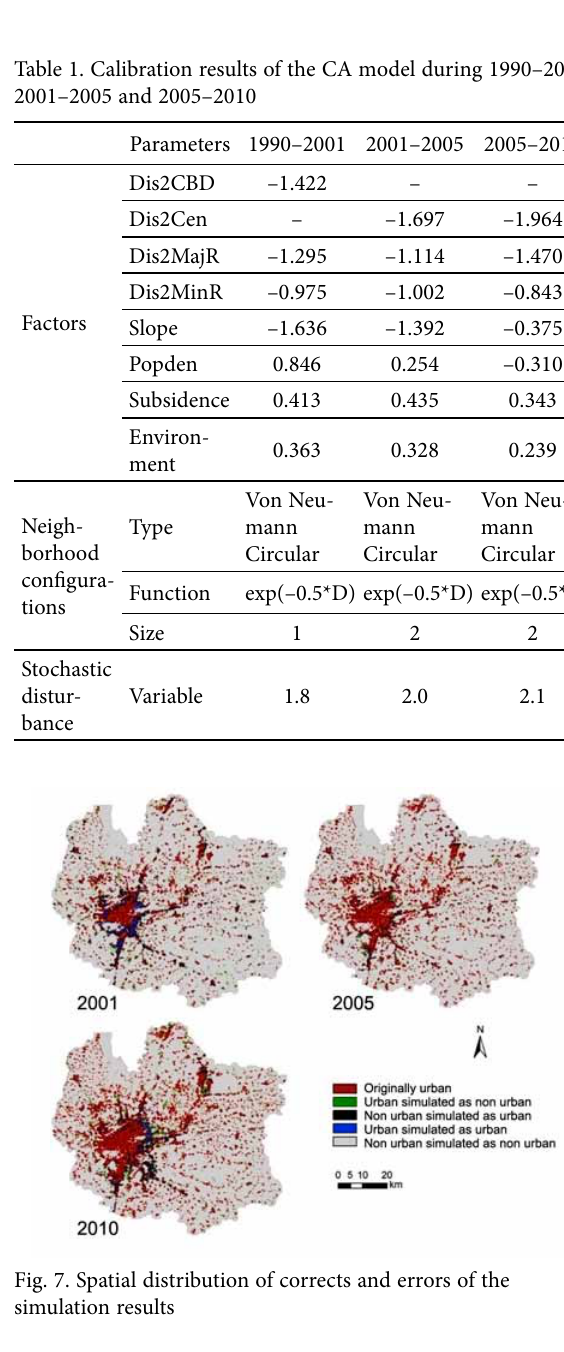
Fig. 6. Variation of figure of merit and Rd values response to neighborhood size and random variable variation: a) – the figure of merit value calculated for different neighborhood sizes and random variables and b) – the Rd value calculated for different neighborhood sizes and random variables